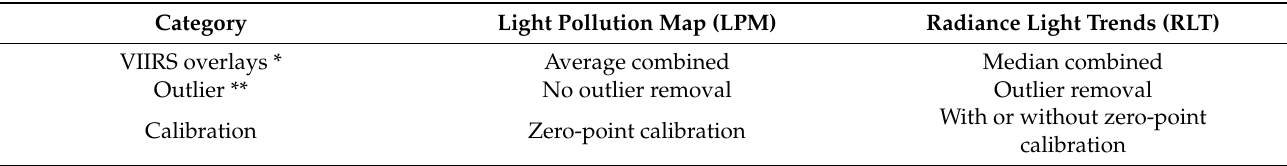
Table A4. The key differences between the Light Pollution Map and Radiance Light Trends (RLT) web mapping services. Source: authors’